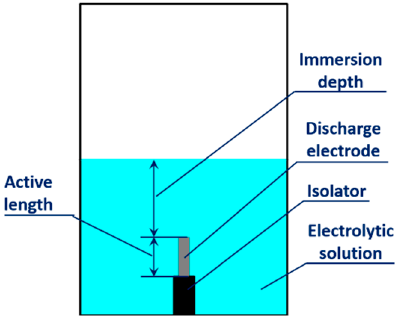
Figure 11. Schemes of the discharge electrode (cathode) positioning in the electrochemical cell applied in [63]. The immersion depth is the distance between the discharge electrode tip and the surface of the electrolytic solution.